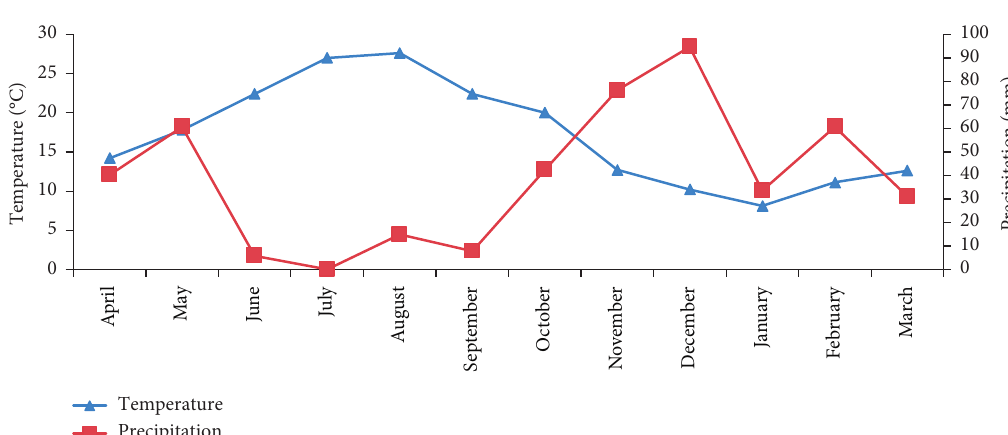
Figure 3: Ombrothermic diagram of the study